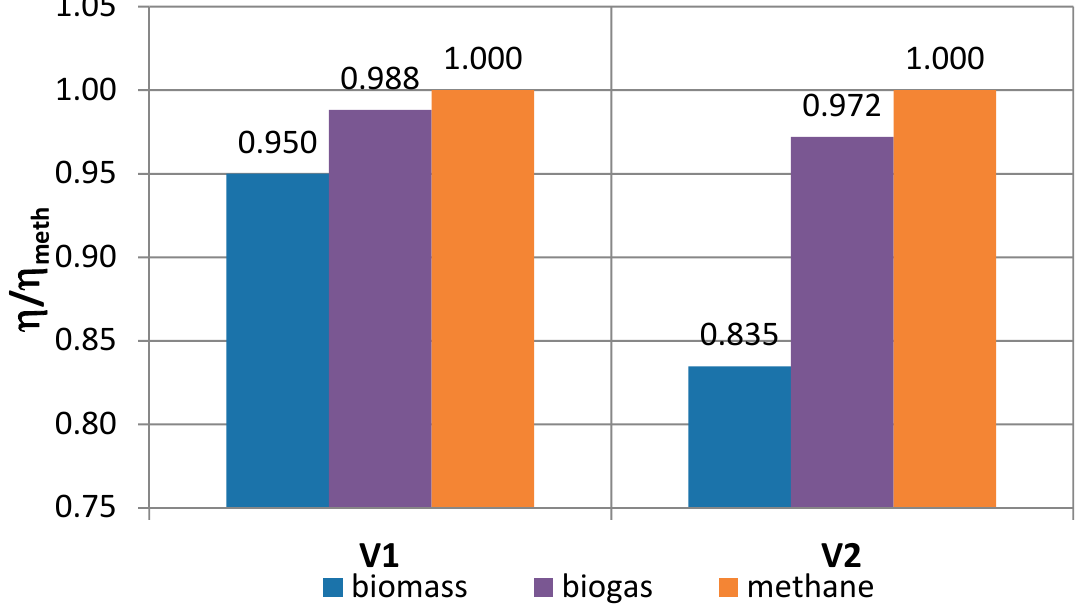
Figure 6. The influence of the structure of the cycle and calorific value of the fuel on the relative e ffi ciency (referred to methane) for both variants of turbine sets.